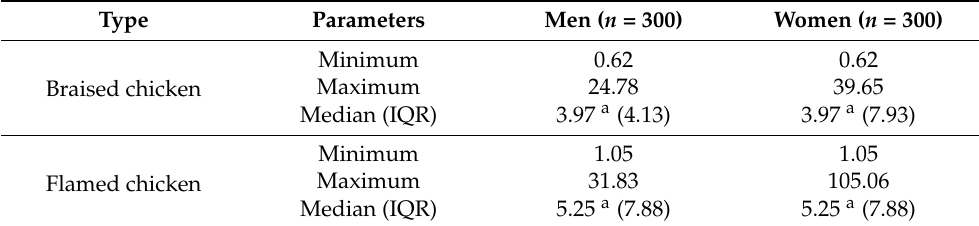
Table 4. Estimated daily consumption of braised and flamed chicken (g/day) [23].